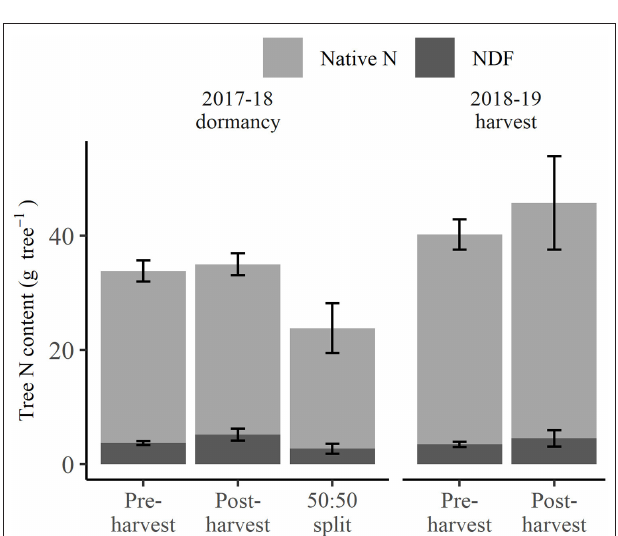
FIGURE 2 | Amount of nitrogen derived from fertilizer (NDF) and unlabeled N (Native N) for N-treated trees destructively harvested at the 2018 dormancy (excluding fruit and leaf foliage) and the 2019 harvest (including fruit and leaf) under different N fertigation treatments. Error bars represent ± SEM, n =